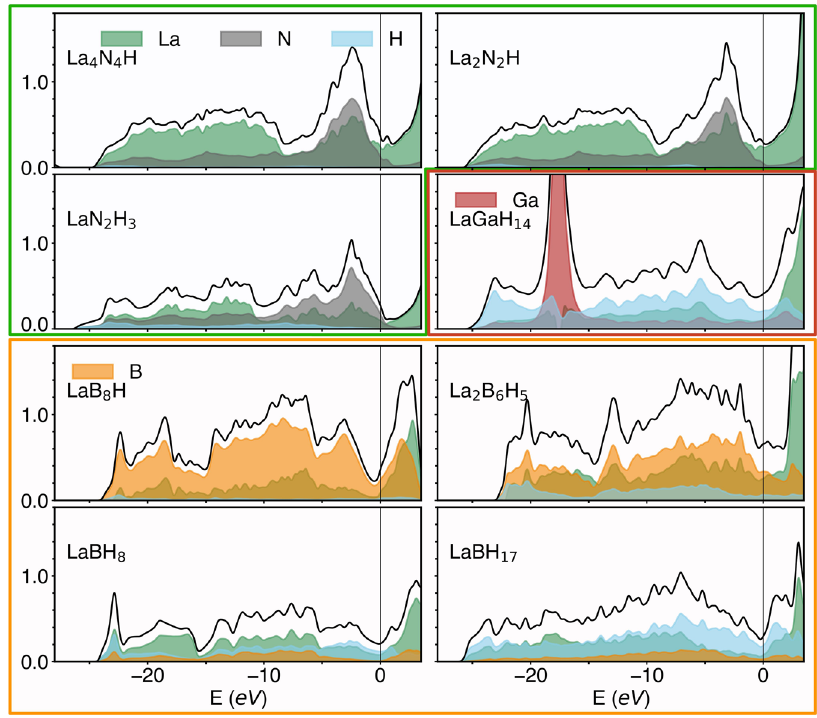
Fig. 3 Total and atom-projected DOS in units of spin − 1 eV − 1 for stable La – N – H, La – B – H phases, and metastable LaBH 17 and LaGaH 14 at 300 GPa. The total DOS and its projection onto La, N, B, Ga, and H are shown as black lines, and green, gray, orange, red, and blue fi lled lines, respectively. The Fermi energy is set as the